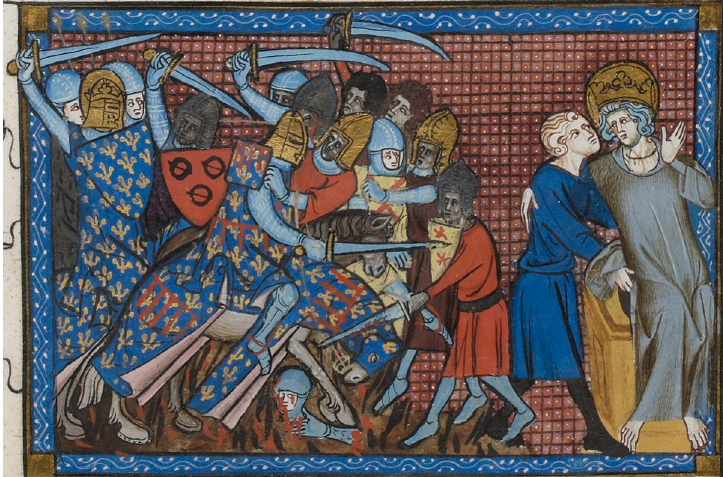
Fig 8. The battle of al Mansourah (1250), as depicted in Guillaume de Saint-Pathus’, Vie et Miracles de saint Louis, 1330–1350, showing the curved swords of the Islamic troops in contrast to the straight-edged swords of the European crusaders. (Image: Gallica Digital library/Biblioth è que nationale de France. De´partement des Manuscrits. MS Fr.5716, fol.199).